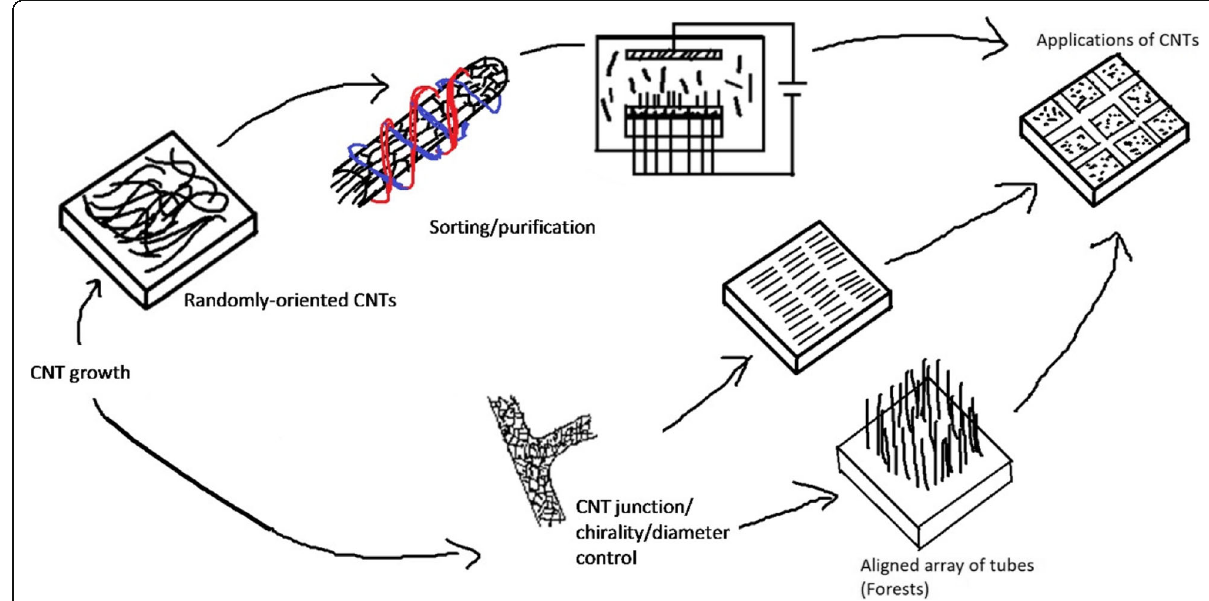
Fig. 4 Schematic outline of the paper. In this review, progress on controlling the assembly and integration of CNTs from individual tubes (i.e. chirality, junctions and diameter) to various purification, assembly, alignment techniques and integration of large numbers of nanotubes for a wide range of applications is